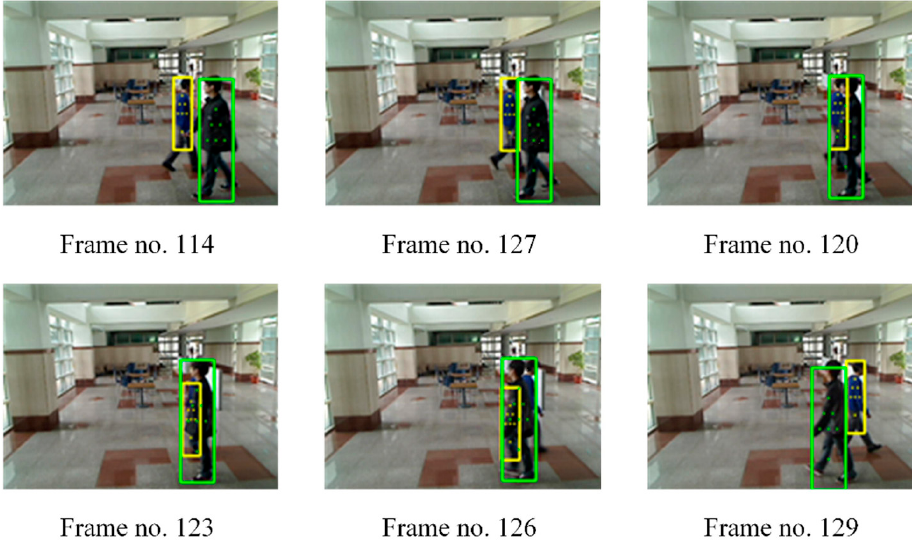
Figure 16. (Frame no. 114 ~ 129) from Cam2 in two People tracking scene.